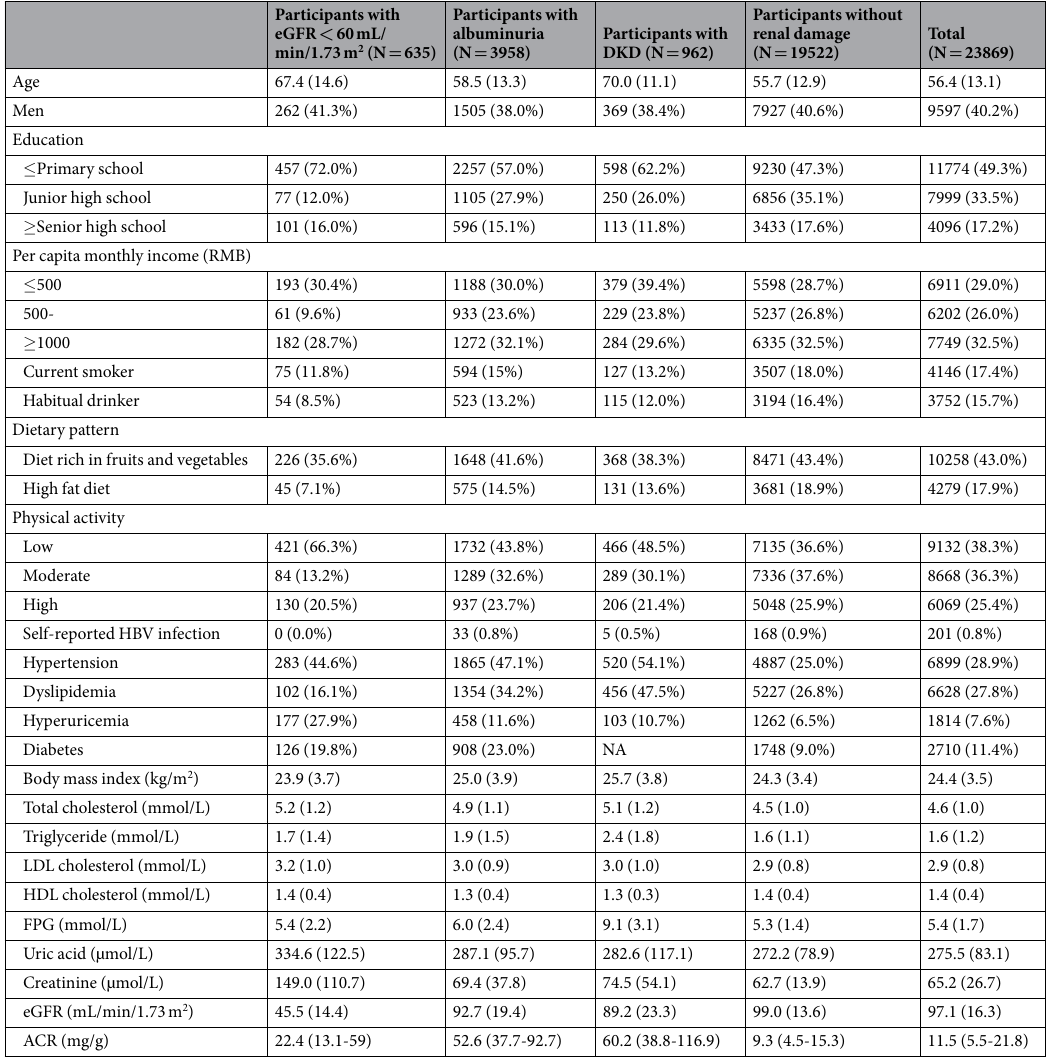
Table 1. General characteristics of participants according to indicators of renal damage Note: Data were n (%) or mean (standard deviation) except for ACR, which was presented as median with interquartile range. Abbreviations: DKD, diabetic kidney disease; HBV, hepatitis B virus; LDL, low density lipoprotein; HDL, high density lipoprotein; eGFR, estimated glomerular filtration rate; FPG, fast plasma glucose ACR, albumin: creatinine ratio; NA, not